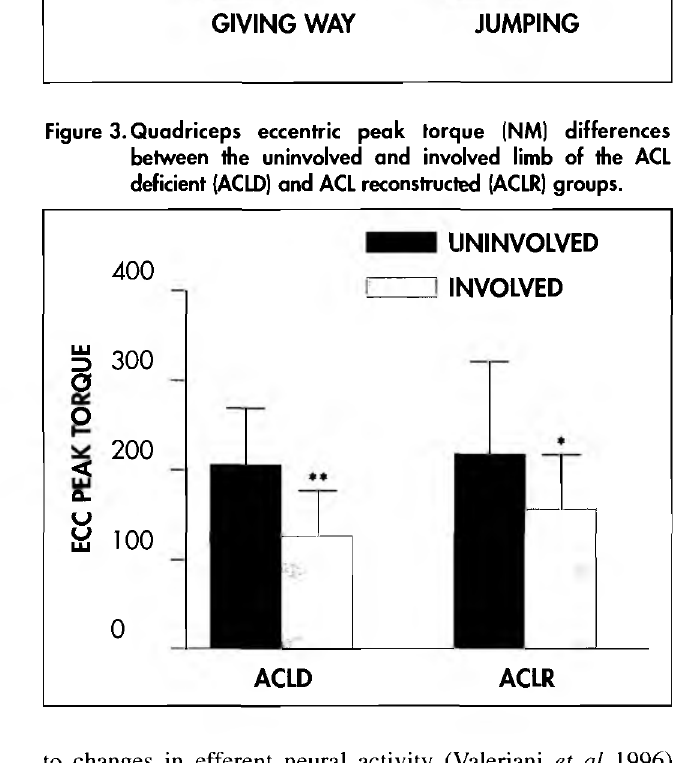
Figure 3. Quadriceps eccentric peak torque (NM) differences between the uninvolved and involved limb of the ACL deficient (ACLD) and ACL reconstructed (ACLR)